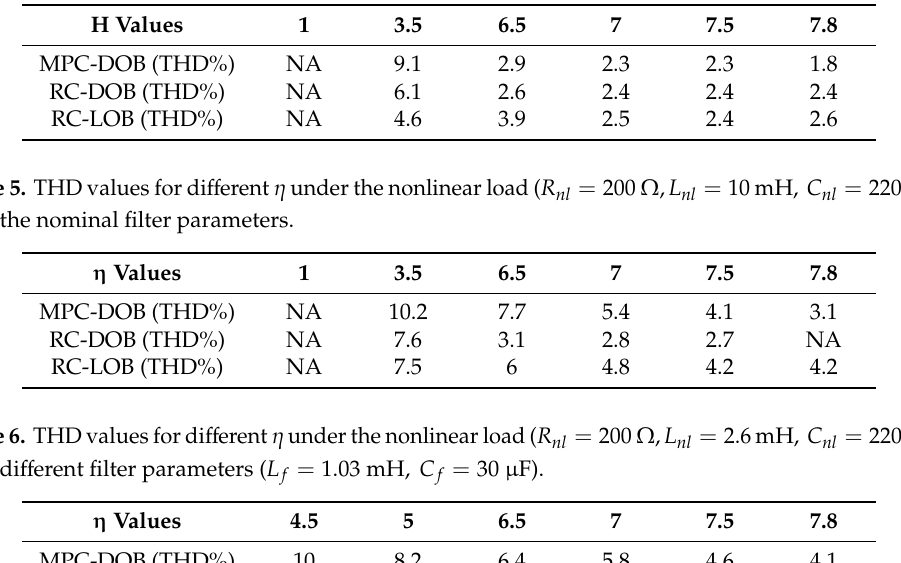
Table 4. THD values for di ff erent η under the inductive load ( R L = 10 Ω , L L = 10 mH).